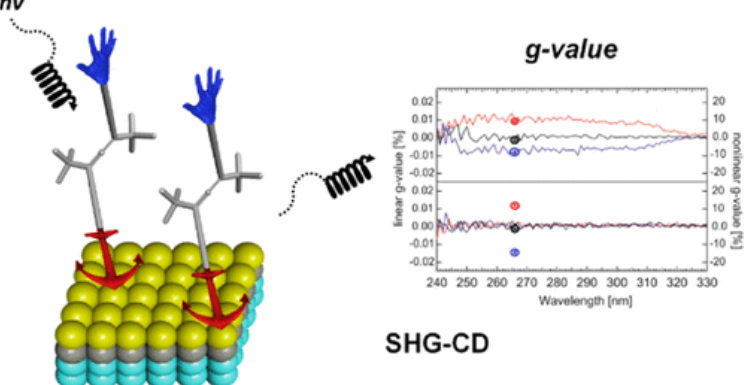
Figure 19. Device-Compatible Chiroptical Surfaces through Self-Assembly of Enantiopure Allenes [87].